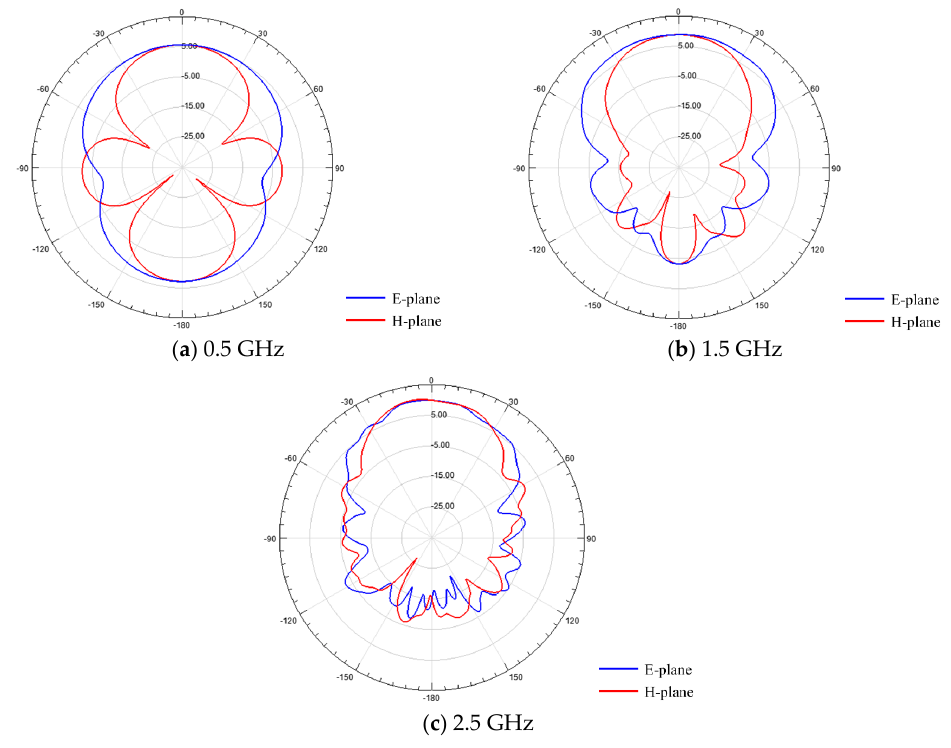
Figure 8. Simulated E-plane and H-plane radiation patterns of the designed Vivaldi antenna. ( a ) 0.5 GHz, ( b ) 1.5 GHz, and ( c ) 2.5 GHz.